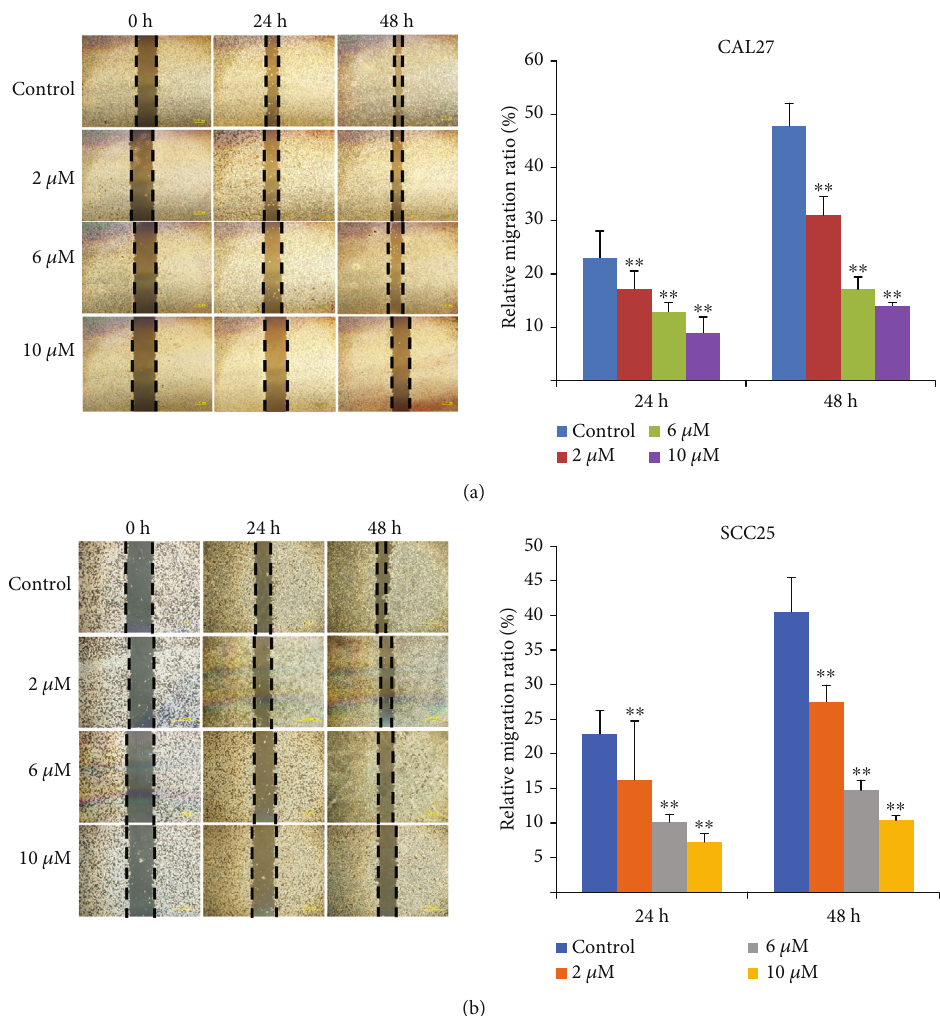
Figure 9: MK2206 2HCl suppressed the OSCC cell migration ability. (a) MK2206 2HCl inhibited the CAL27 cell migration ability by scratch migration assay. (b) MK2206 2HCl inhibited SCC25 cell migration ability by scratch migration assay. All data are presented as the mean ± SD : ∗∗ P < 0 : 01 as compared with the control group. Magni fi cation ×